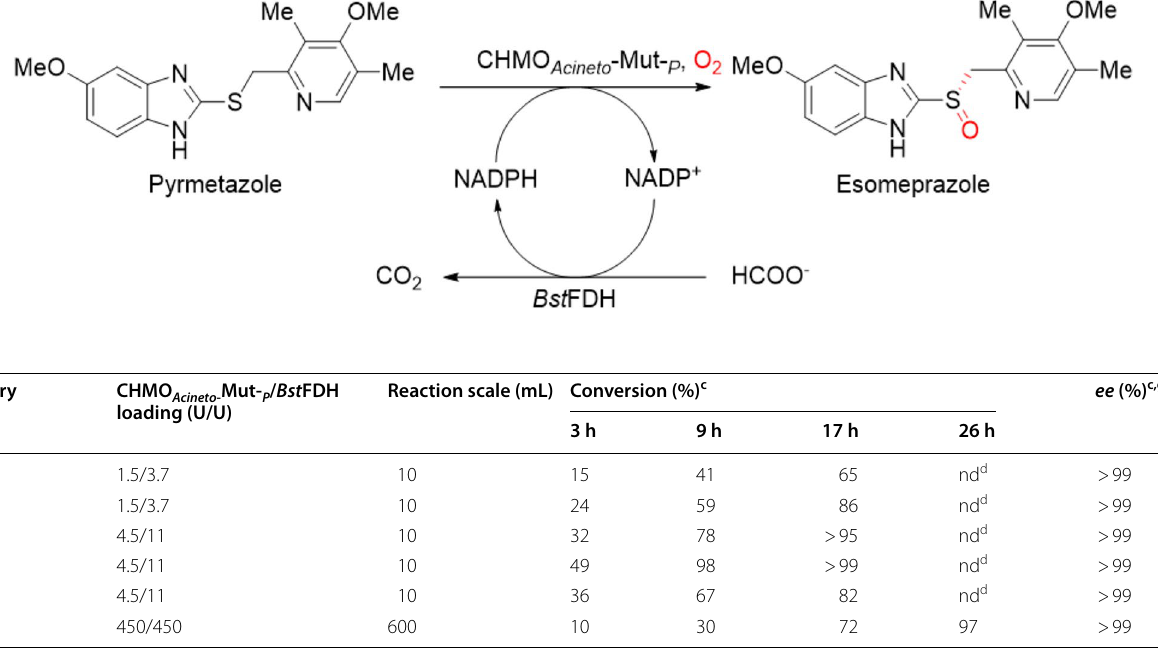
Table 3 Optimization of bio‑oxidation of pyrmetazole by employing recombinant yeast secretion